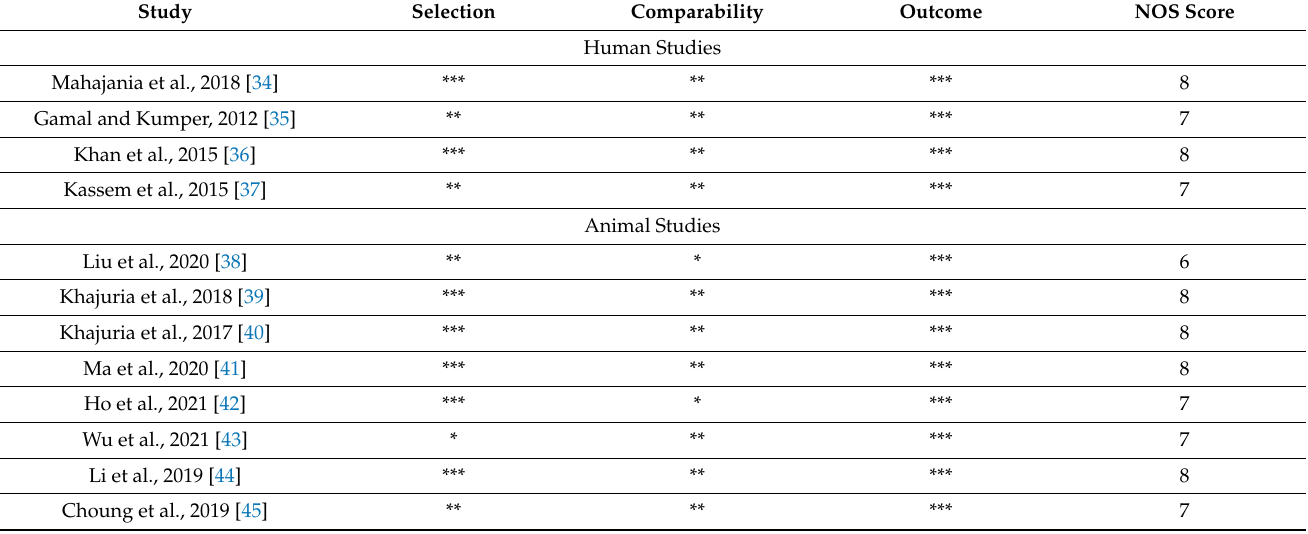
Table 1. NOS Scale of the included articles.